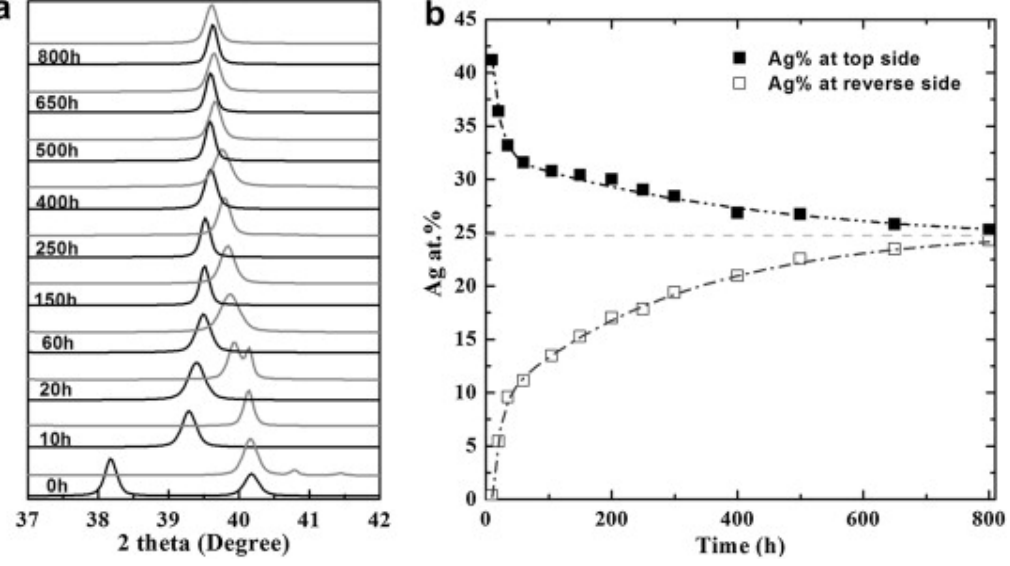
Figure 11. ( a ) 111 XRD reflections from the top (black) and reverse surface (grey) of a PdAg membrane during alloying at 550 °C and ( b ) convergence of the corresponding alloy lattice parameters [53] , with permission from © Elsevier.